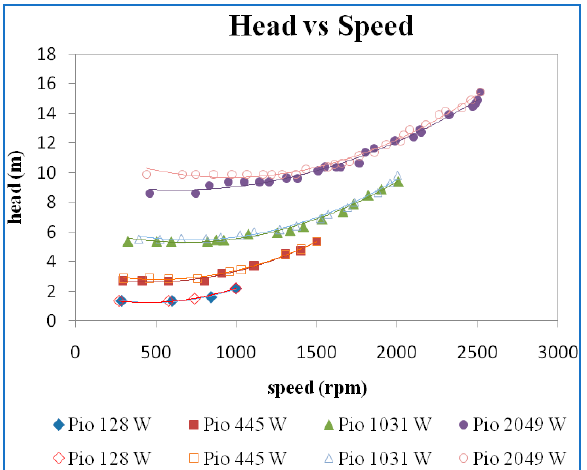
Figure 5. Head vs. speed at a guide vane opening of 10 mm.